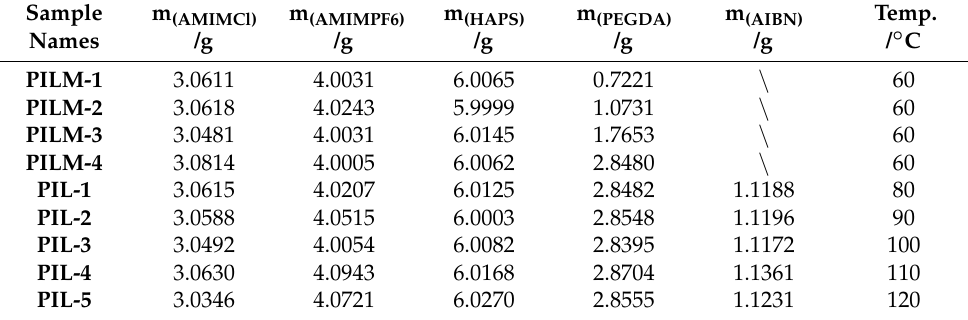
Table 1. The general recipe used in the preparation of poly(ionic liquid)s (PILs a ).